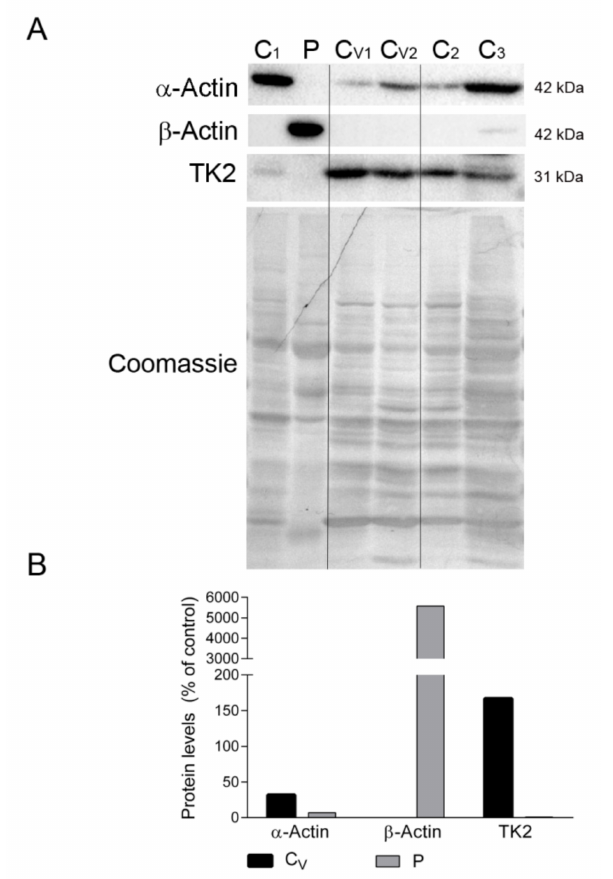
Figure 5. Actin isoforms and TK2 in diaphragm. ( A ) Representative Western blotting of skeletal muscle α -actin, microtubule β -actin and TK2 in diaphragm homogenates of non-ventilated controls (C) (n = 3), ventilated controls (Cv, n = 2), and the patient (P). Shown below is a representative Coomassie blue-stained gel. ( B ) Densitometry analysis: protein levels were normalized to total protein loading according to Coomassie blue staining. Data are expressed as percentage of non- ventilated control values. Abbreviations: TK2, thymidine kinase